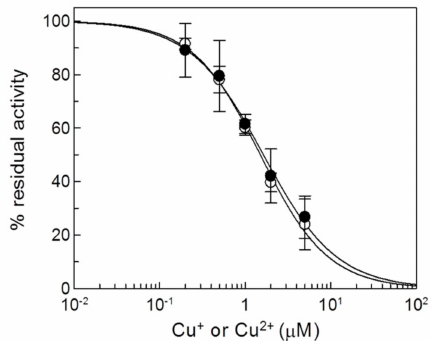
Figure 2. Dose-response analysis of copper e ff ect on the native CAC. Proteoliposomes reconstituted with the CAC extracted from rat liver mitochondria were incubated with ( indicated concentrations for 1 min, and then the transport activity was measured by adding 0.1 mM [ 3 H]carnitine and stopped after 10 min as described in Materials and Methods. Percent of residual activity with respect to the control, without copper treatment, is reported. The values are the means ± SD from three independent experiments.